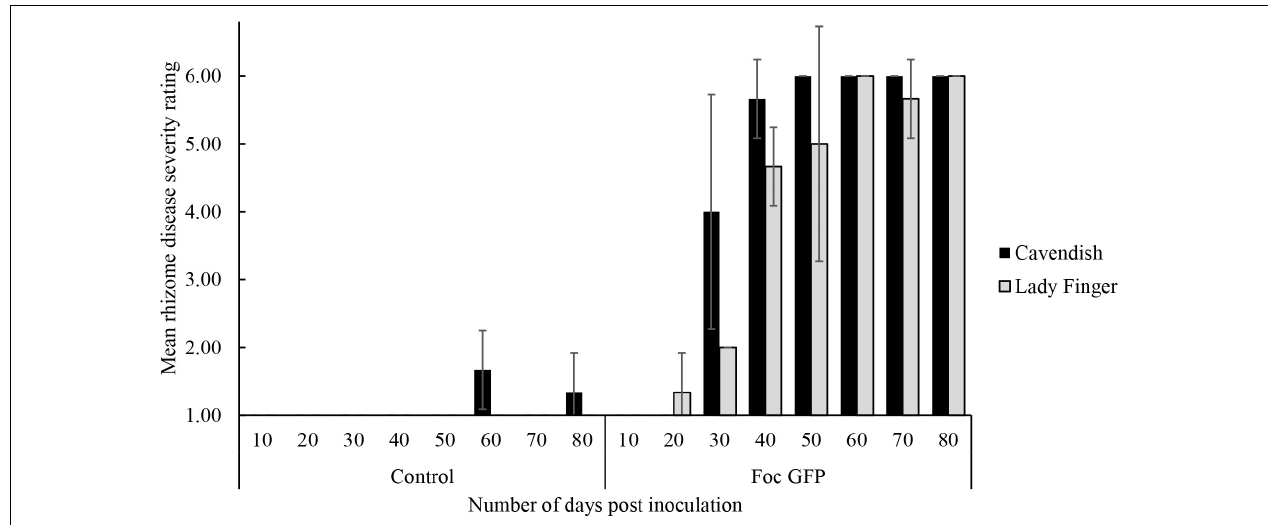
FIGURE 2 | Internal symptoms as mean rating of disease severity, according to the scale in Table 1 , in the rhizomes of Cavendish and Lady Finger banana plants recorded in days post inoculation (dpi) with Foc GFP infested millet or uninoculated control millet. At each time point, three plants of each treatment were sampled. Data are shown as mean ± standard deviation of the three independent replications ( n =